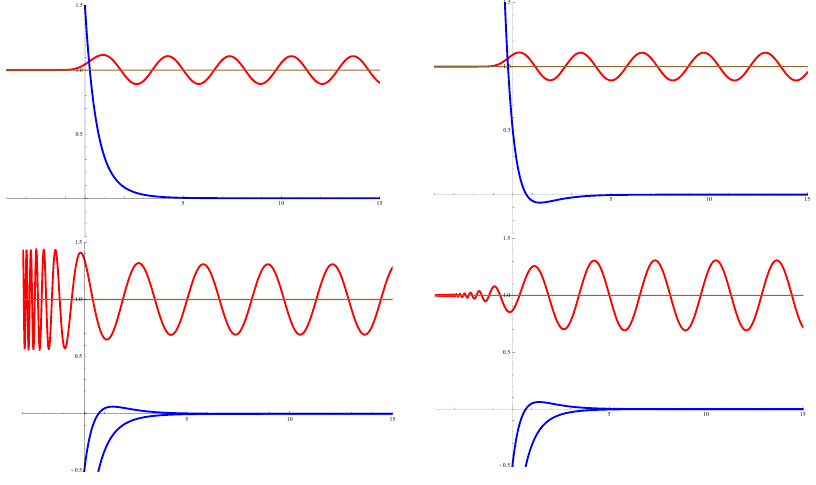
Figure 10 . Blue: Morse potential V ( φ ) . Red: wavefunction solution for k = 2 with energy value k 2 / 4 = 1 marked by the brown line. Top left: νλ > 0 , ξ > 0 . Top right: νλ > 0 , ξ < 0 . Bottom left: νλ < 0 , ξ > 0 . Bottom right: νλ < 0 , ξ < 0 . When νλ < 0 , the Morse potential is